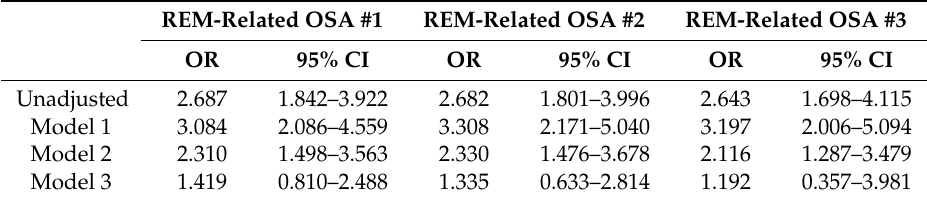
Table 4. Association between REM-related OSA and women aged under 50 years. REM-Related OSA #1 REM-Related OSA